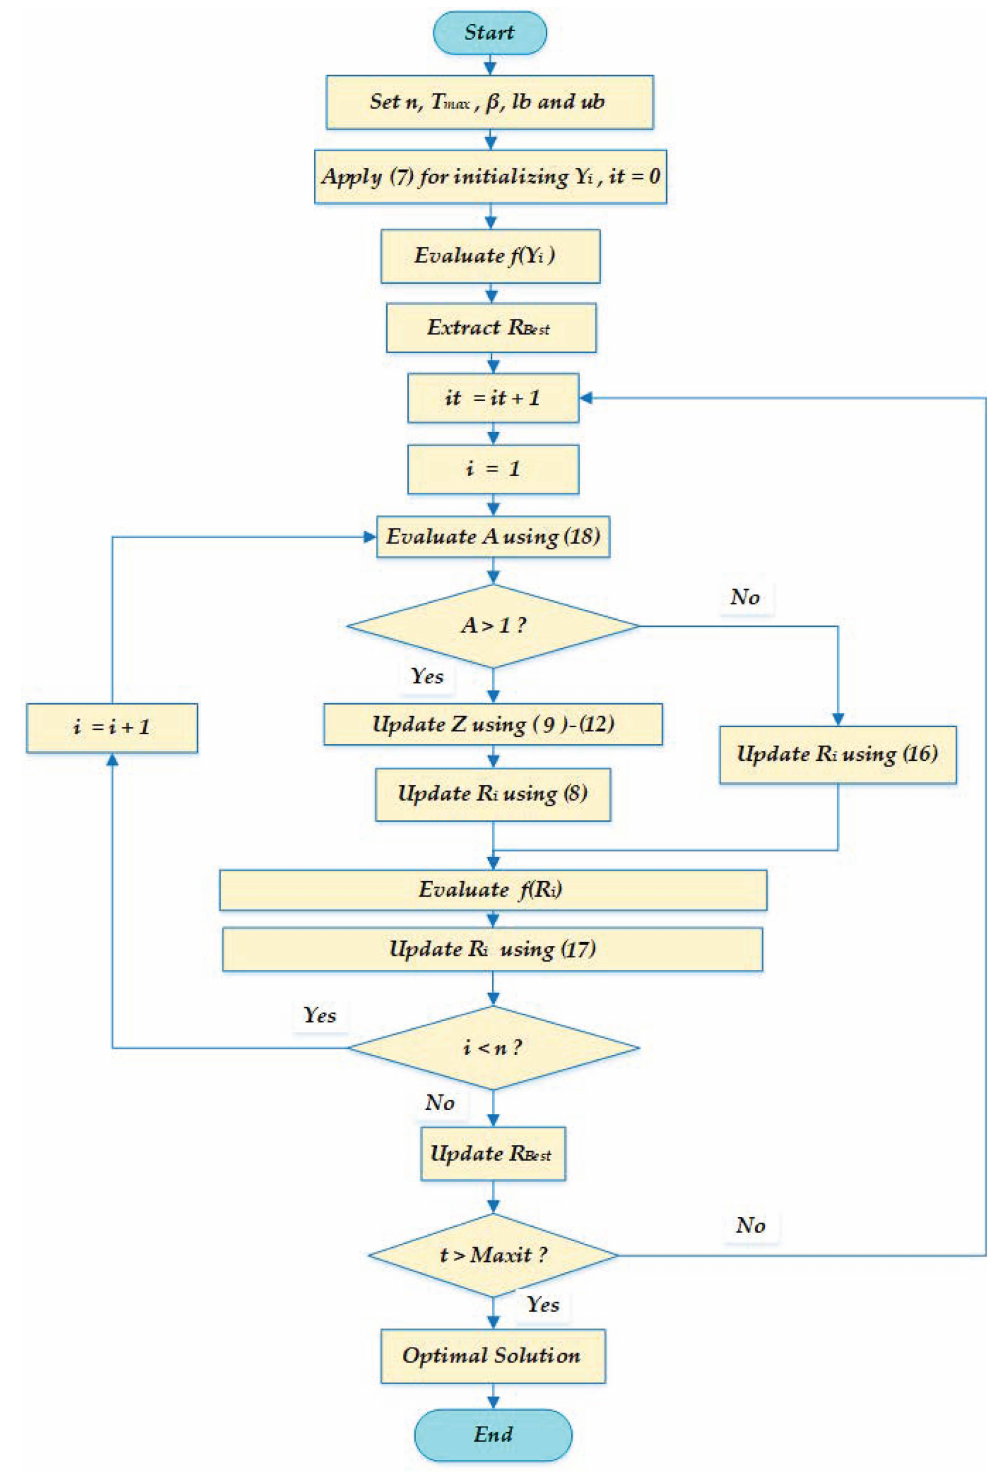
Figure 3. Main steps of the proposed